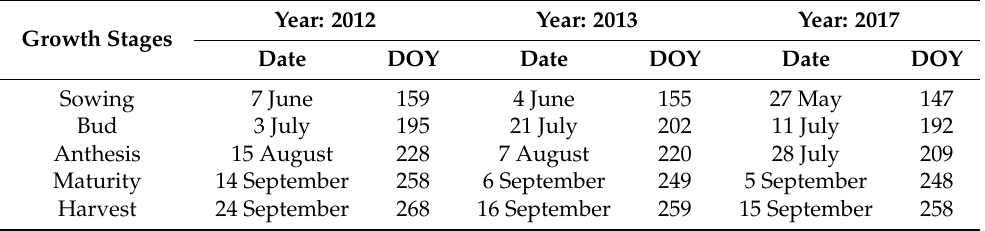
Table 2. Phenology data of sunflower in 2012, 2013, and 2017. DOY denotes day of year. Growth Stages